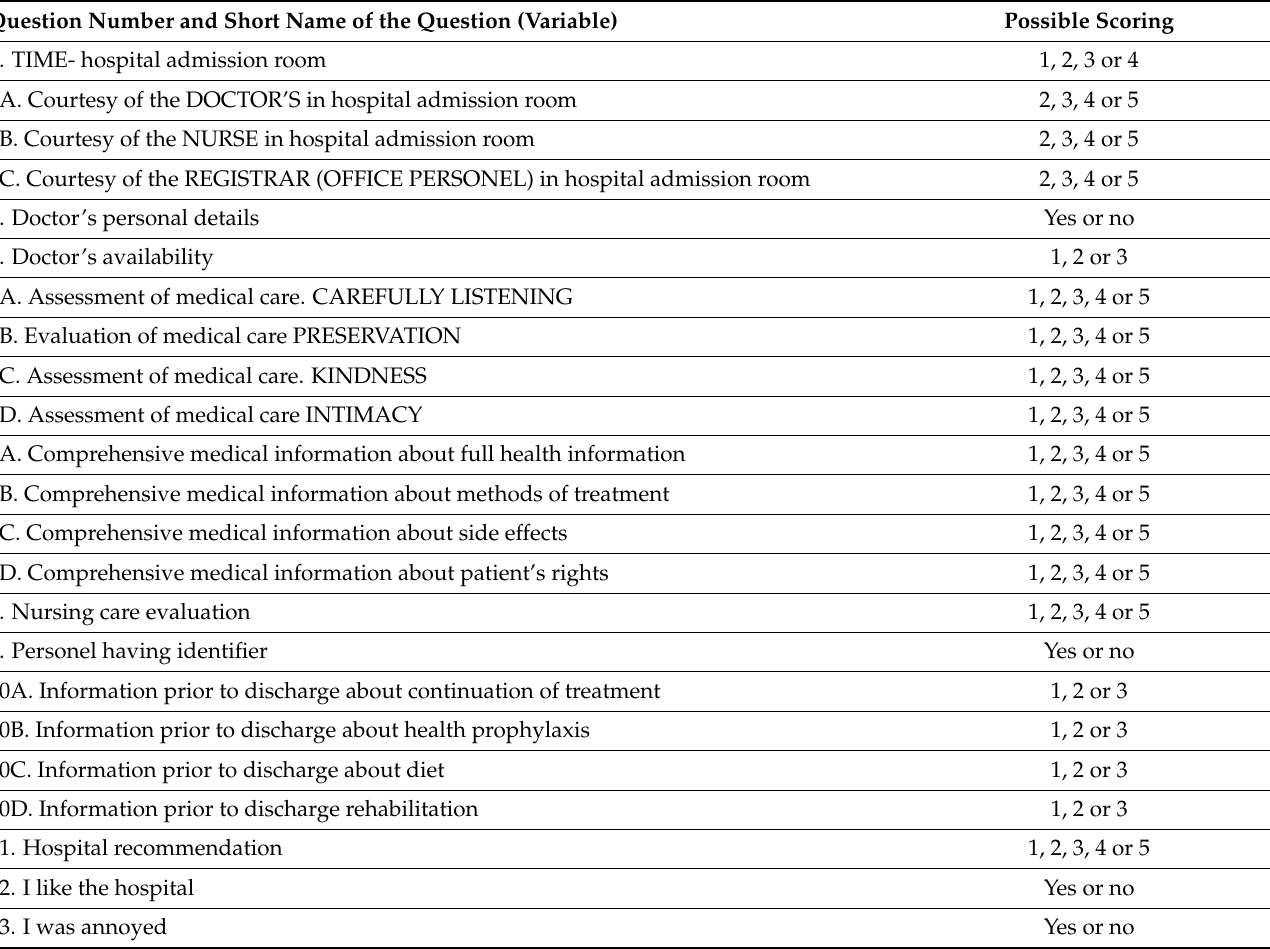
Table A1. Questions (variables) and possible scoring that were used to determine the total